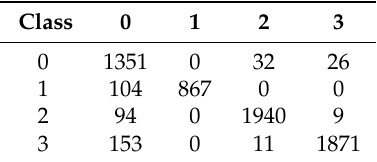
Table 3. Confusion matrix of the support vector machine